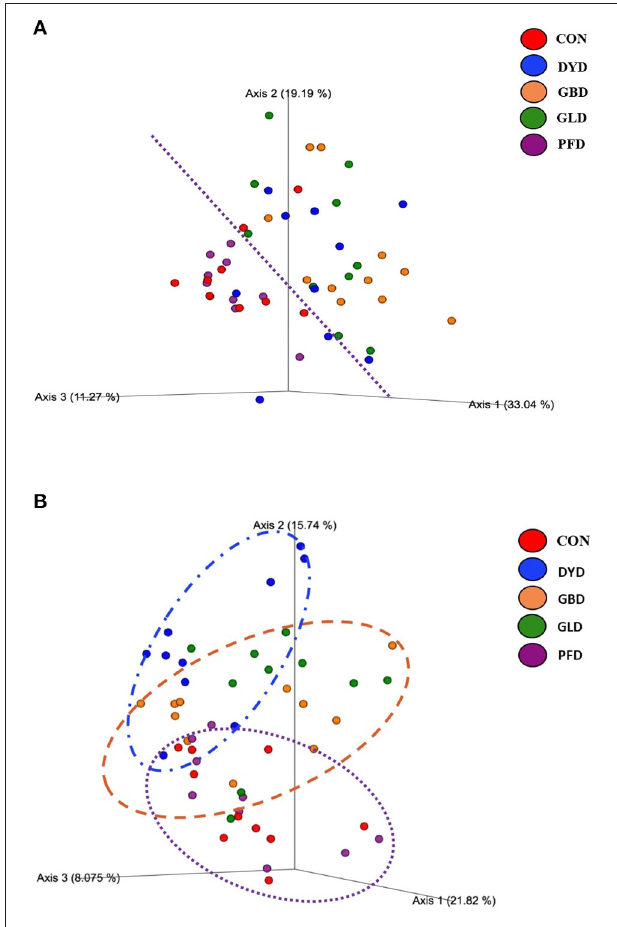
FIGURE 4 | Principal coordinated plots of weighted (A) , and unweighted (B) UNIFRAC distances of fecal microbial communities of dogs fed diets containing legumes or yeast as the primary protein source. CON, Poultry by-product meal control; GBD, Garbanzo bean; GLD, Green lentil; PFD, Peanut flour; DYD, Dried